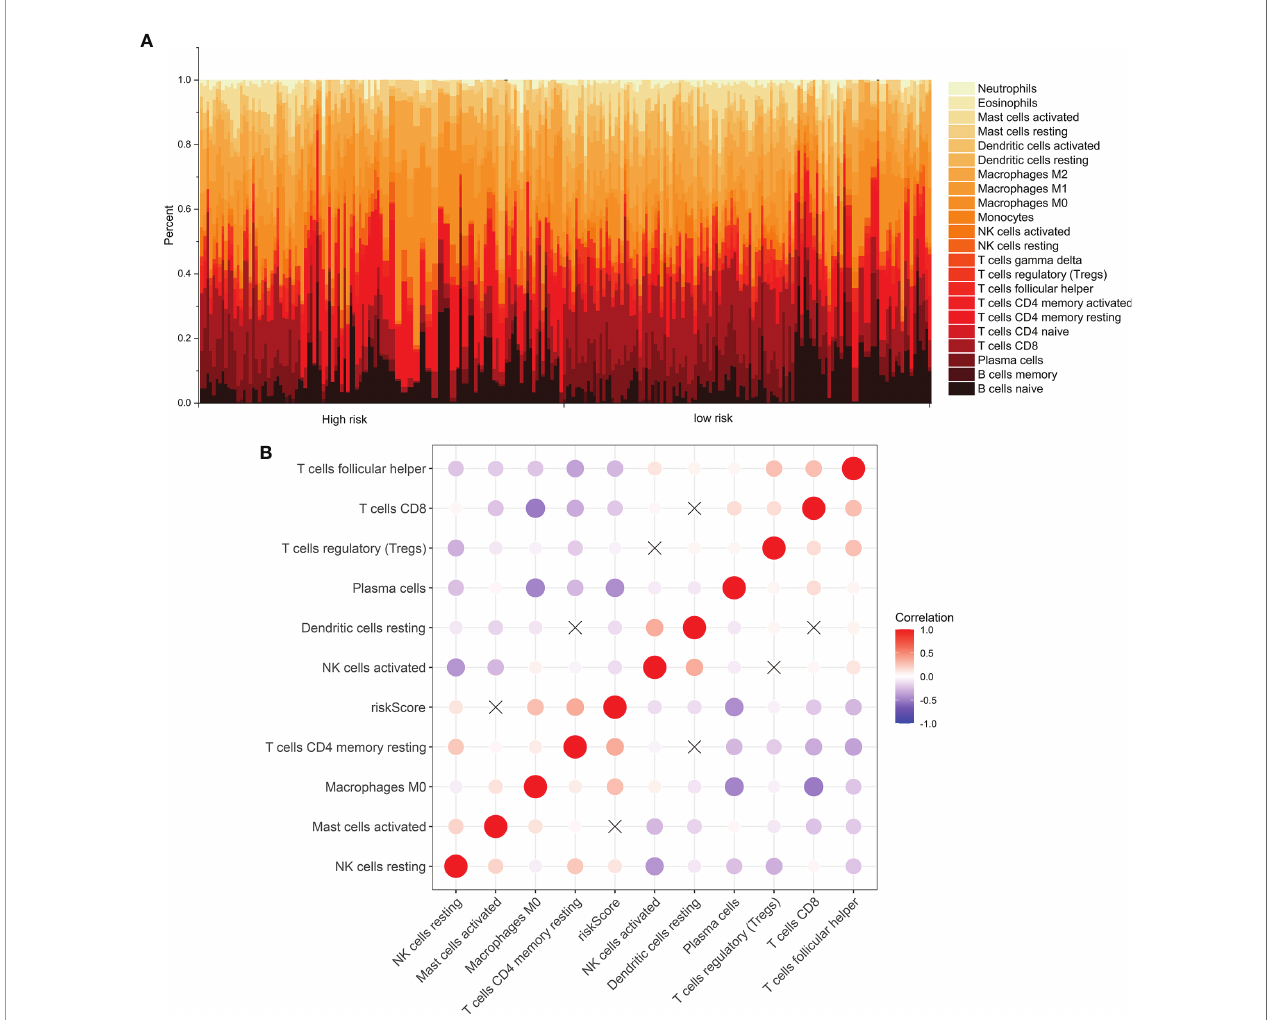
FIGURE 4 | Immune cell in fi ltration analysis. (A) The distribution of 22 kinds of immune cells between high- and low- risk groups via the CIBERSORT algorithm. (B) Heatmap showing the interaction between immune cells and the risk score among laryngeal cancer